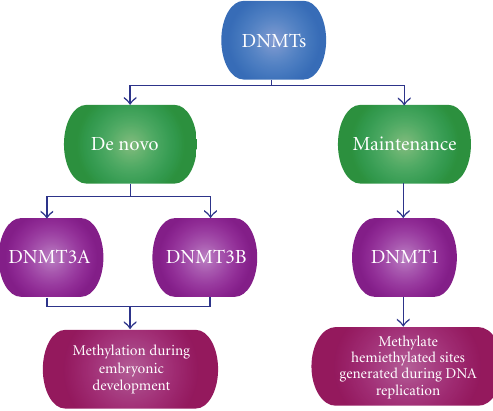
Figure 2: Classification of DNMTs. DNMTs can be classified into de novo and maintenance. De novo DNMTs are involved in methylation during embryonic development, and maintenance DNMTs are involved in methylation during DNA